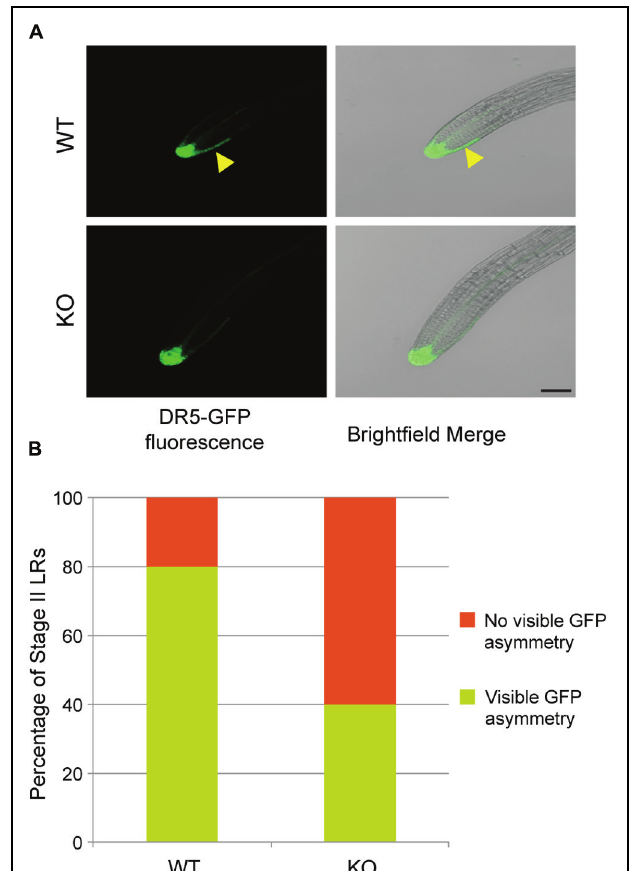
FIGURE 4 | TNO1 helps mediate auxin response asymmetry at lateral root (LR) tips. (A) Representative confocal images of stage II LR tips of WT and tno1 expressing the auxin-responsive DR5rev:GFP reporter. Yellow arrowheads indicate asymmetry of the auxin reporter GFP expression. Scale bar = 50 µ m. (B) The percentage of stage II LRs displaying an asymmetric auxin response pattern. A total of 30 stage II LRs from at least six seedlings were